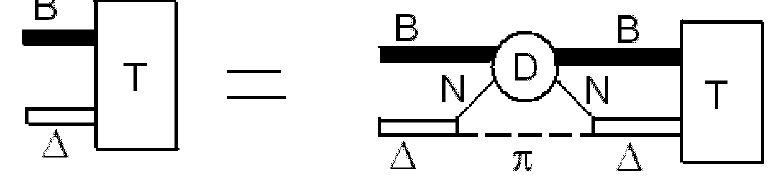
Figure 1. Diagrammatic representation of the B Δ T -matrix integral equation from π NB Faddeev equations with separable pairwise interactions where B = N , Δ [5,